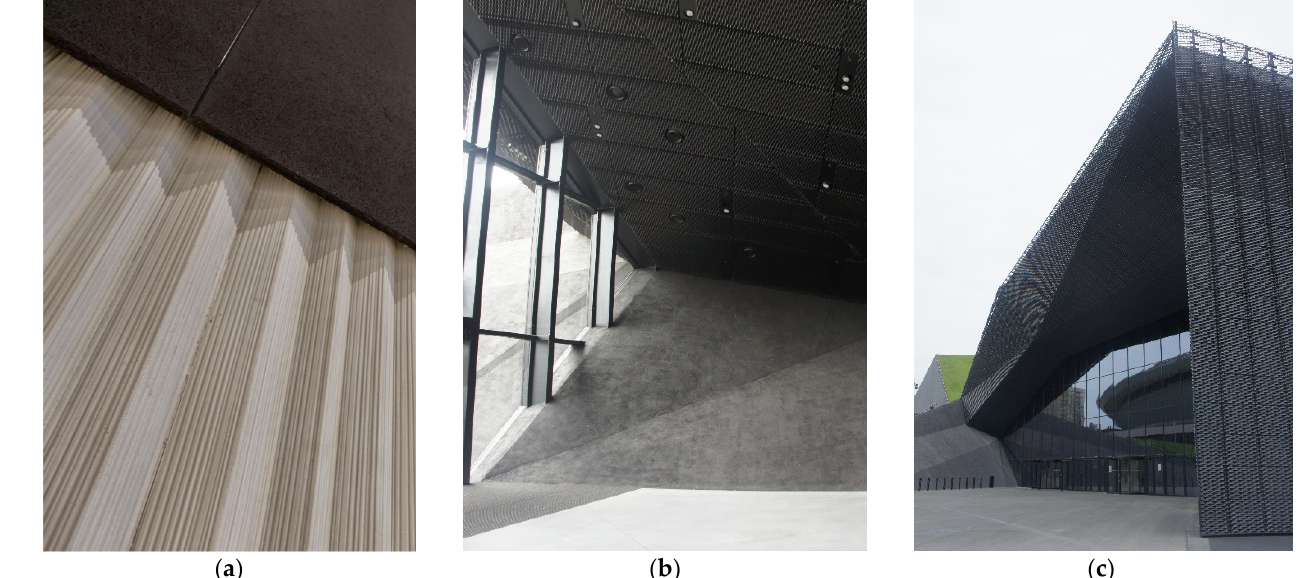
Figure 3. International Congress Centre, Katowice 2015, JEMS Architects. ( a ) The sound absorbing wall cladding in the multifunctional space, (photo by A.K. Kłosak); ( b ) fragment of the main hallway, (photo by M. Celadyn); ( c ) main entrance, (photo by M. Celadyn).